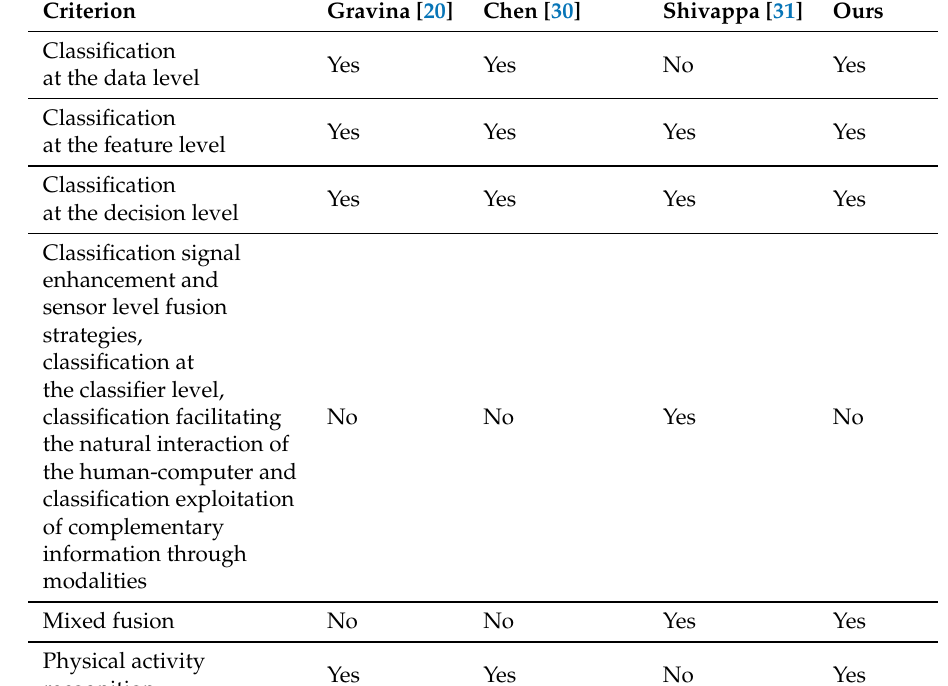
Table 1. Previous surveys comparison, including